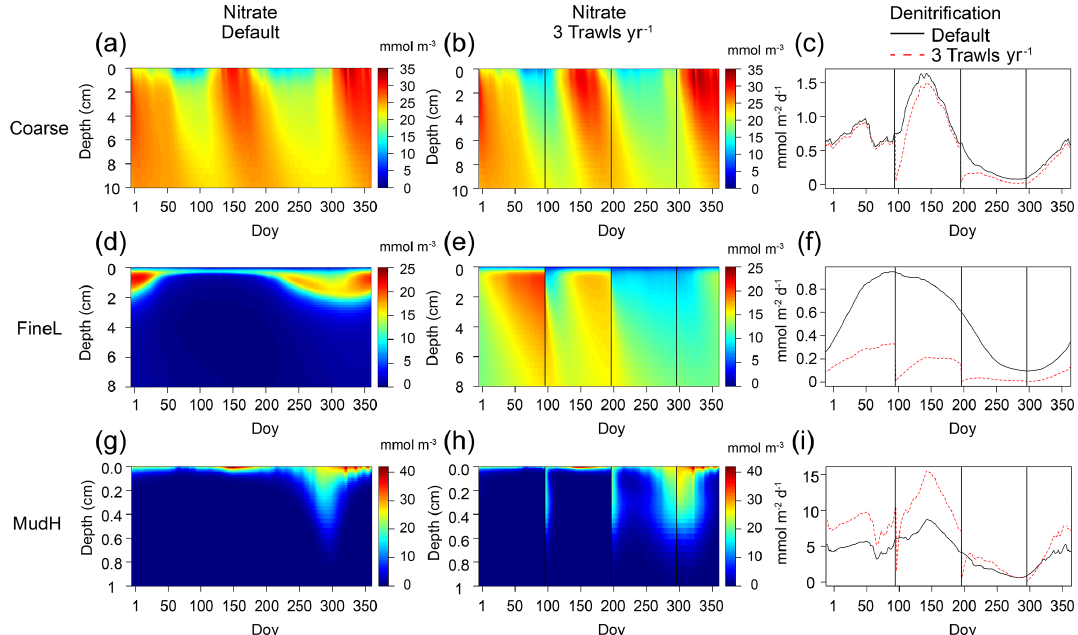
Figure 7. Nitrate concentrations (mmolm − 3 ) in the sediment for a no-trawling simulation (a, d, g) and for three trawls per year (d, e, f) , and associated annual denitrification rates (mmolm − 2 d − 1 , black lines indicate default (zero trawls per year) and red dotted lines indicate the trawling simulation). Represented stations are Coarse (a–c) , FineL (d–f) , and MudH (g–i) . Black vertical lines indicate when trawling events take place. ”Doy” indicates day of